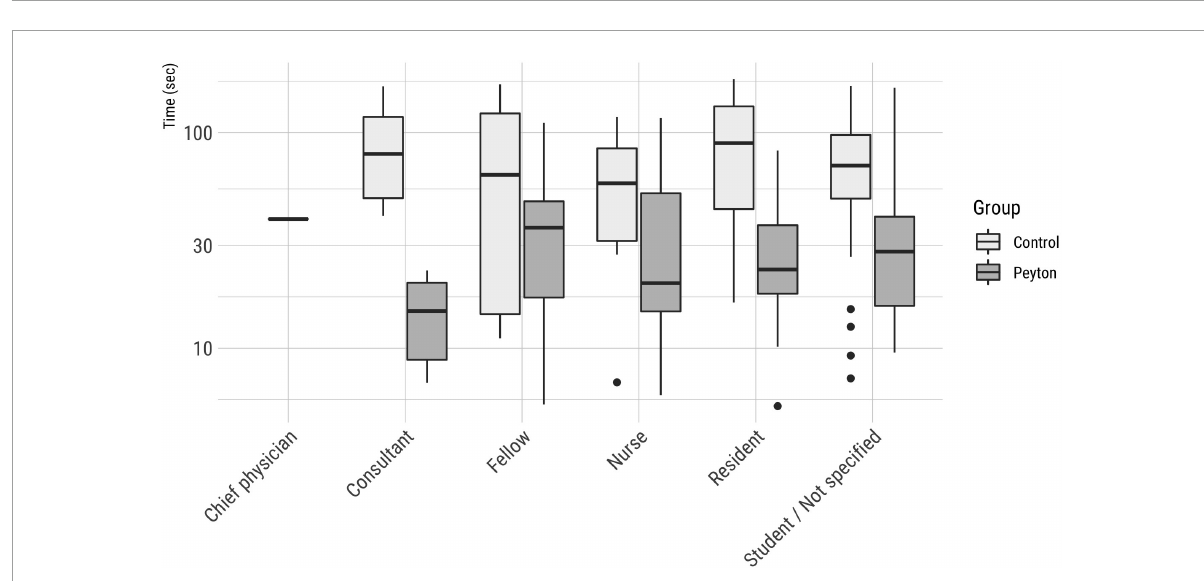
FIGURE4 Fiberoptic-assisted tracheoscopy times according to the participants’ professional status and